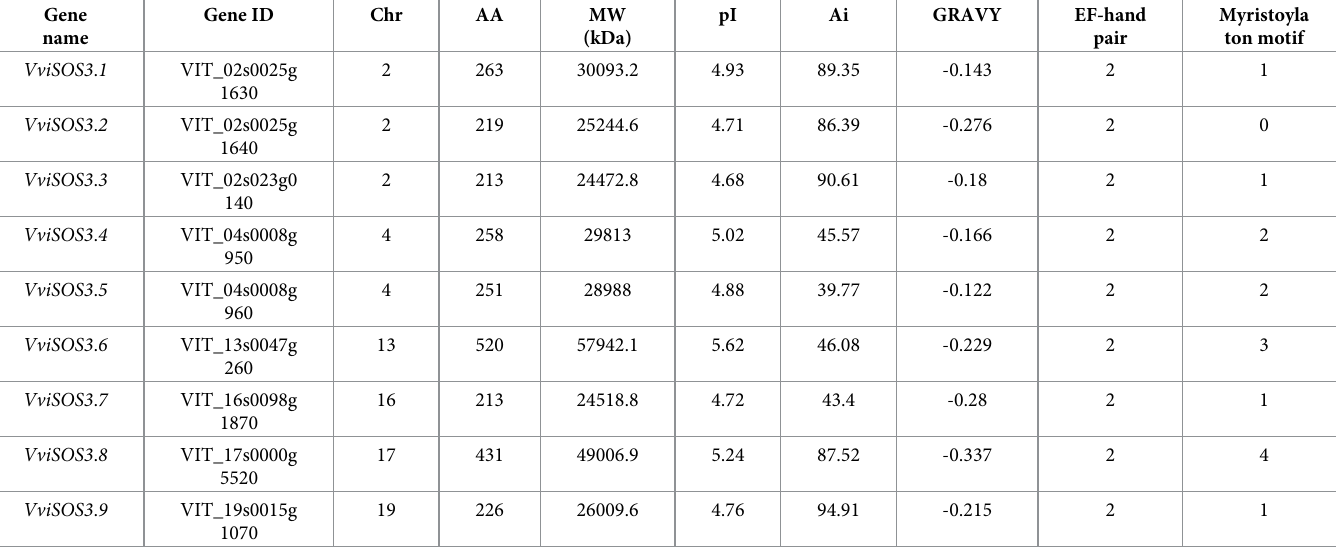
Table 2. SOS3 genes identified in the genome sequence of V . vinifera